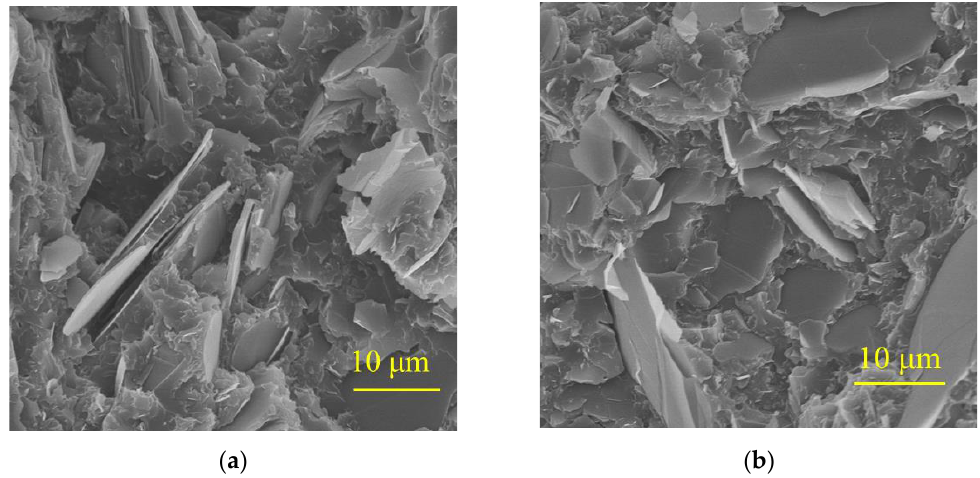
Figure 2. The SEM diagram of the cross-section of the N-BN/EP composite material. ( a ) 10% N-BN/EP; ( b ) 20% N-BN/EP.